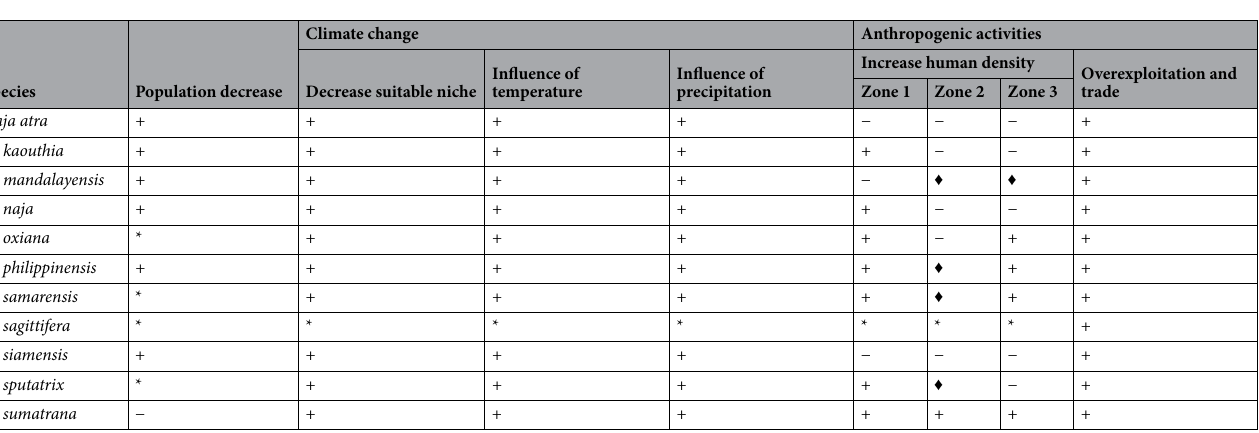
Table 2. Binary assessment denoted by + or − (present or absent) of some quantifiable selection pressures that currently affecting Asian cobras. ♦ As there was no suitable climatic niche, so the population could not be calculated. *No published